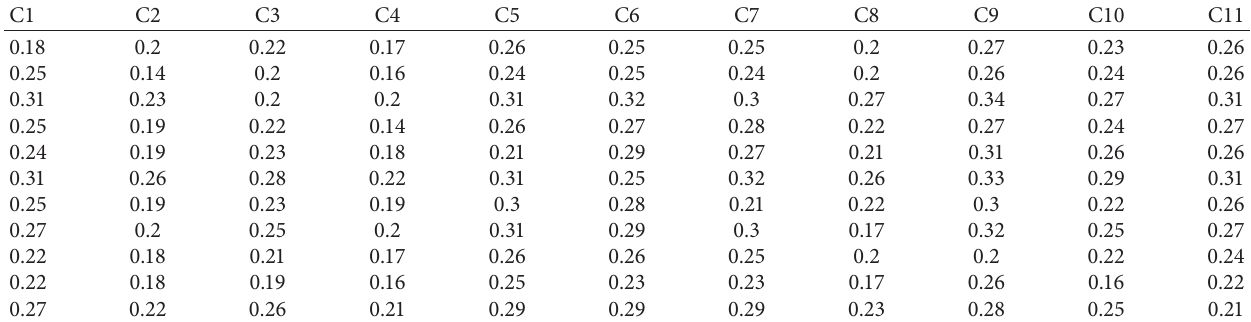
Table 12: Fij matrix